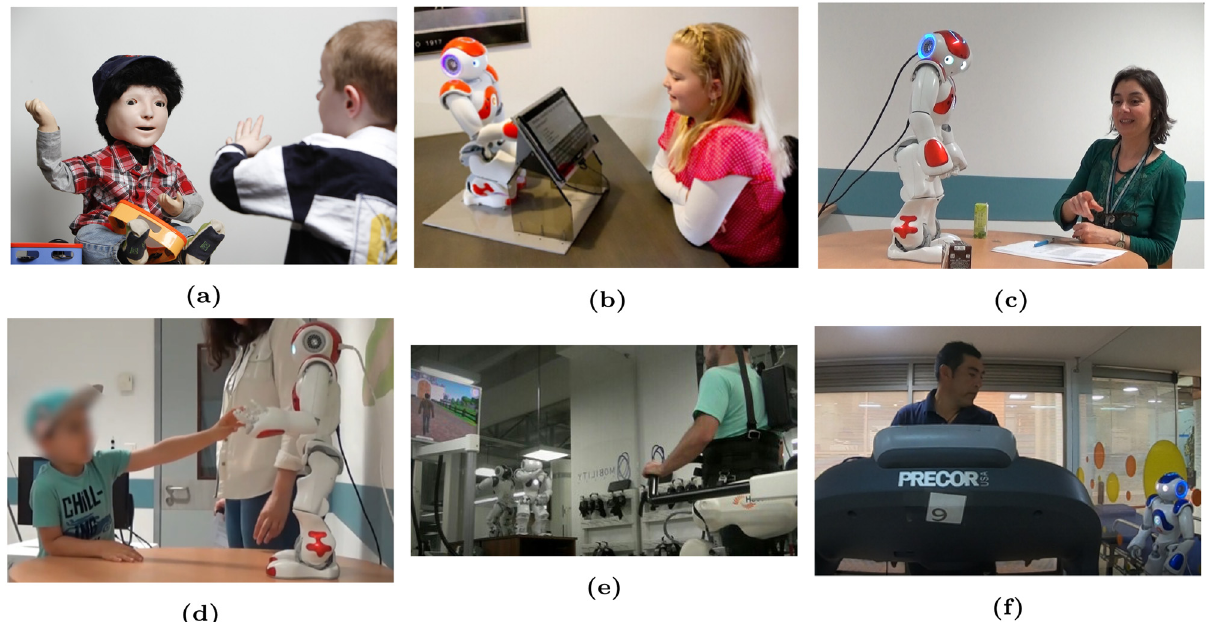
Figure 2: Social robots interacting with people in healthcare settings. ( a ) The social robot Kaspar which has been designed for interactions with children with special needs engaging a child in an activity with educational and therapeutic objectives [ 84 ] ; ( b ) Nao robot playing a self - management educational game with a child with diabetics [ 64 ] ; ( c ) the robot assisting an autism therapist in ASD diagnosis training session [ 68 ] ; ( d ) the robot engaging in therapy tasks with a child with special needs [ 69 ] ; ( e ) the robot as a collaborator promoting engagement and performance for gait rehabilitation of a patient with neurological disorder during a therapy session; ( f ) a training assistant robot providing encouragement and motivation to a patient in a cardiac rehabilitation training session. Image credits. 23